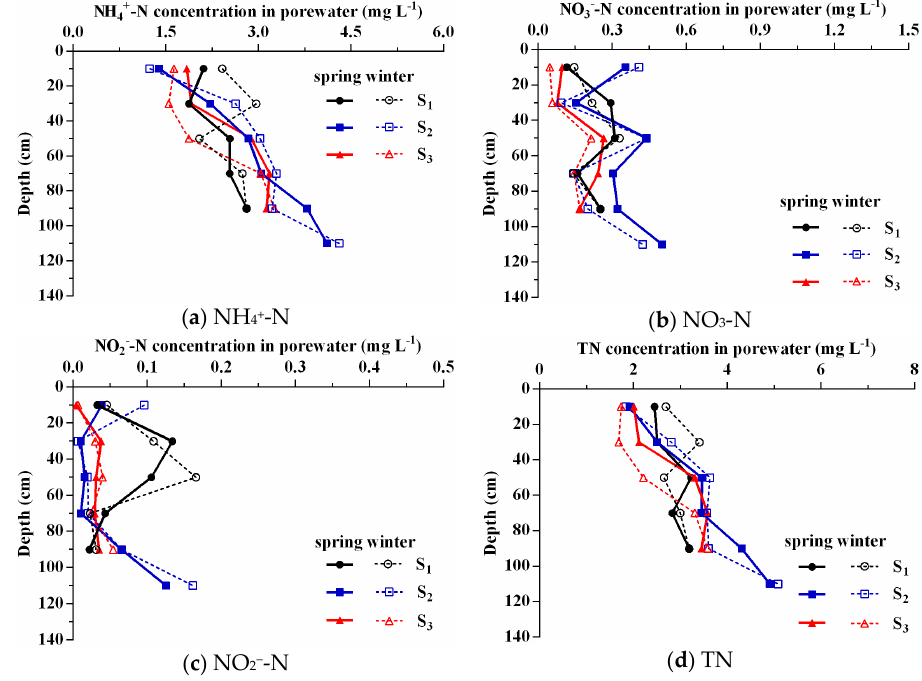
Figure 3. Vertical profiles of nitrogen in the porewater of the hyporheic zone at the south sites in Lake Taihu during spring and winter 2016.